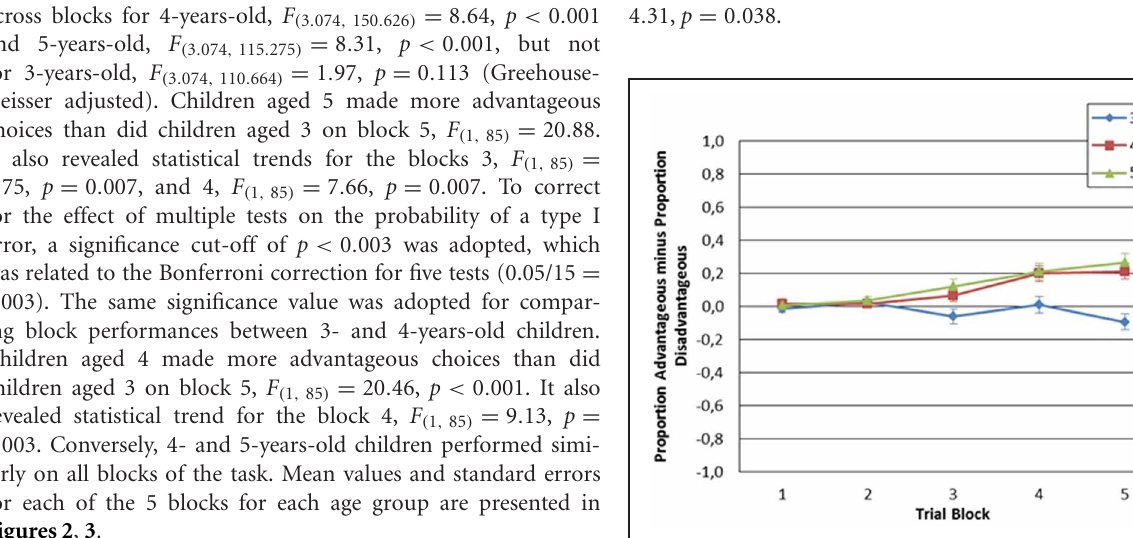
FIGURE 2 | Performance of each of the 3 aged groups across